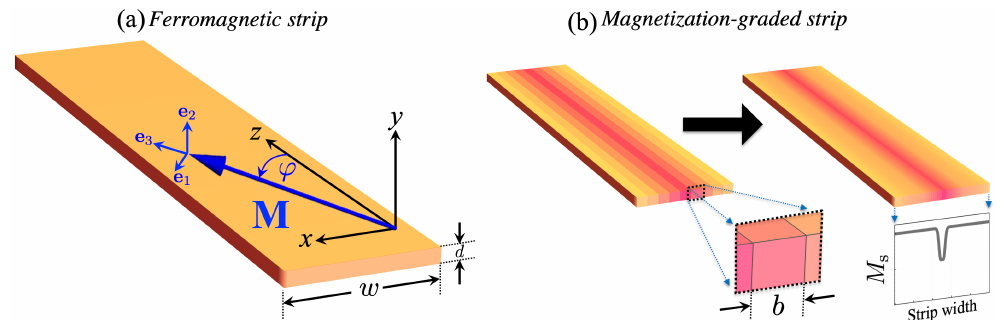
Figure 1. ( a ) Illustration of the coordinate system and the main geometrical parameters of a magnetic strip. In ( b ), a schematic representation of the dynamic matrix approach is shown, where the system is divided into many sub-strips of width b , which allows including magnetic graduation along the width. The color graduation represents the variation of the saturation magnetization along the width of the